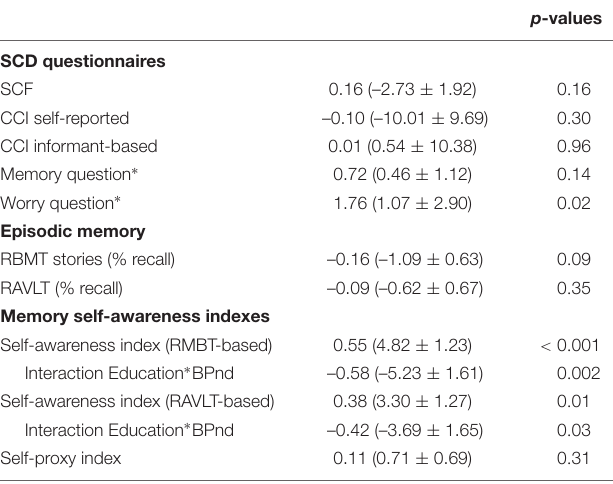
TABLE 2 | Associations between mean cortical amyloid- β load and SCD.